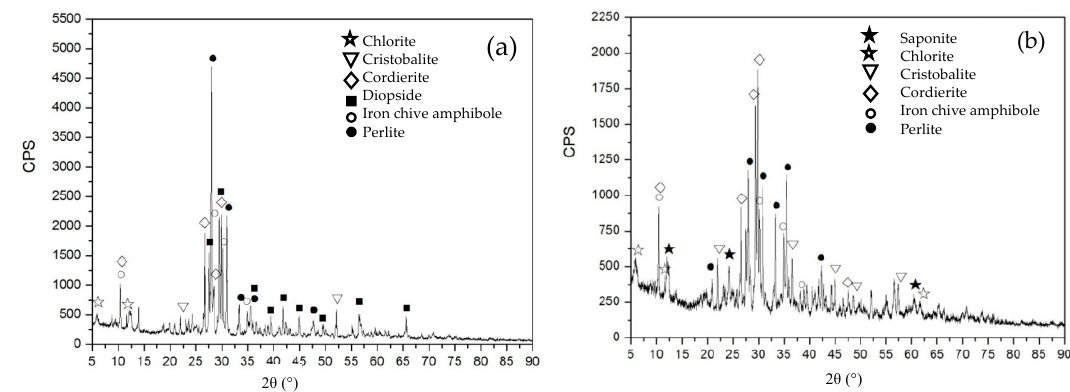
Figure 1. Results of X-ray diffraction (XRD) for coarse tailings and fine tailings: ( a ) coarse tailings; ( b ) fine tailings. Table 1. Mineralogical composition of coarse tailings.